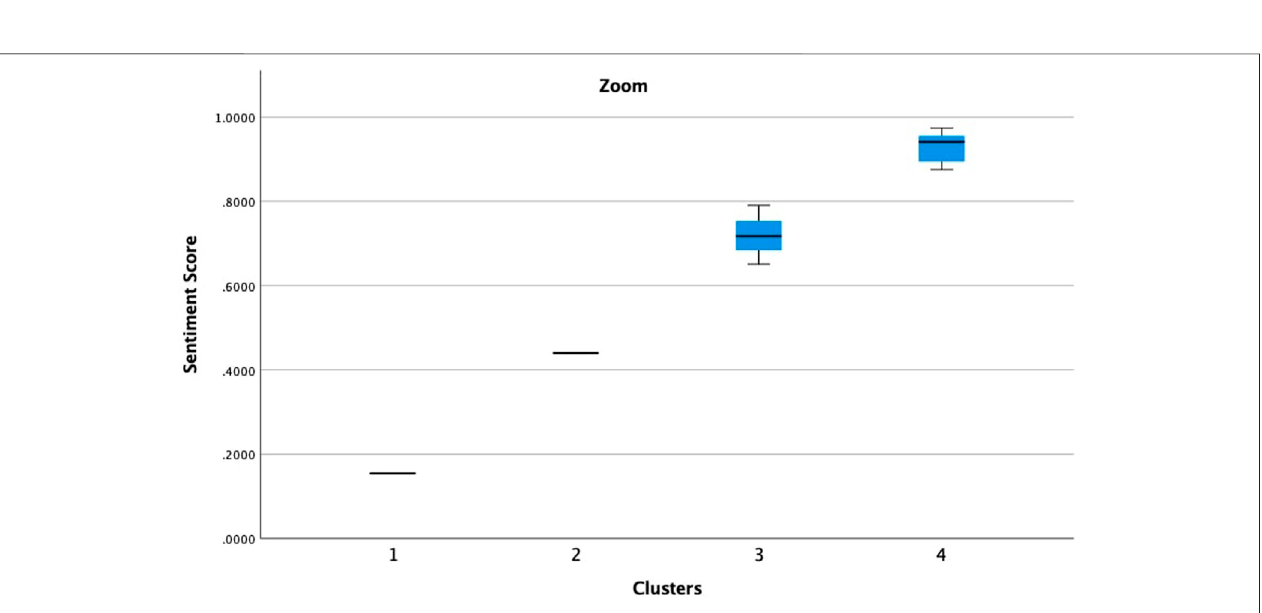
Frontiers in Virtual Reality |